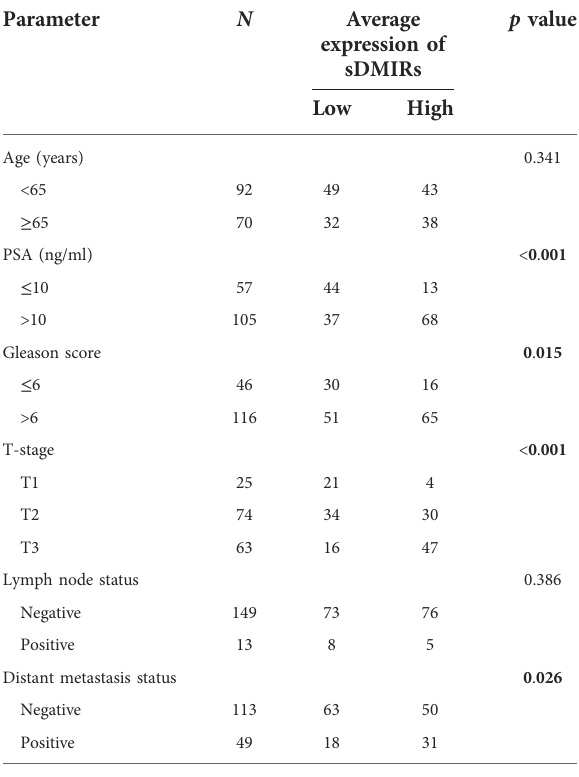
TABLE 3 Relationship between miR-20a-5p and miR-10a-5p expression levels and clinicopathologic factors of BCa patients. Parameter